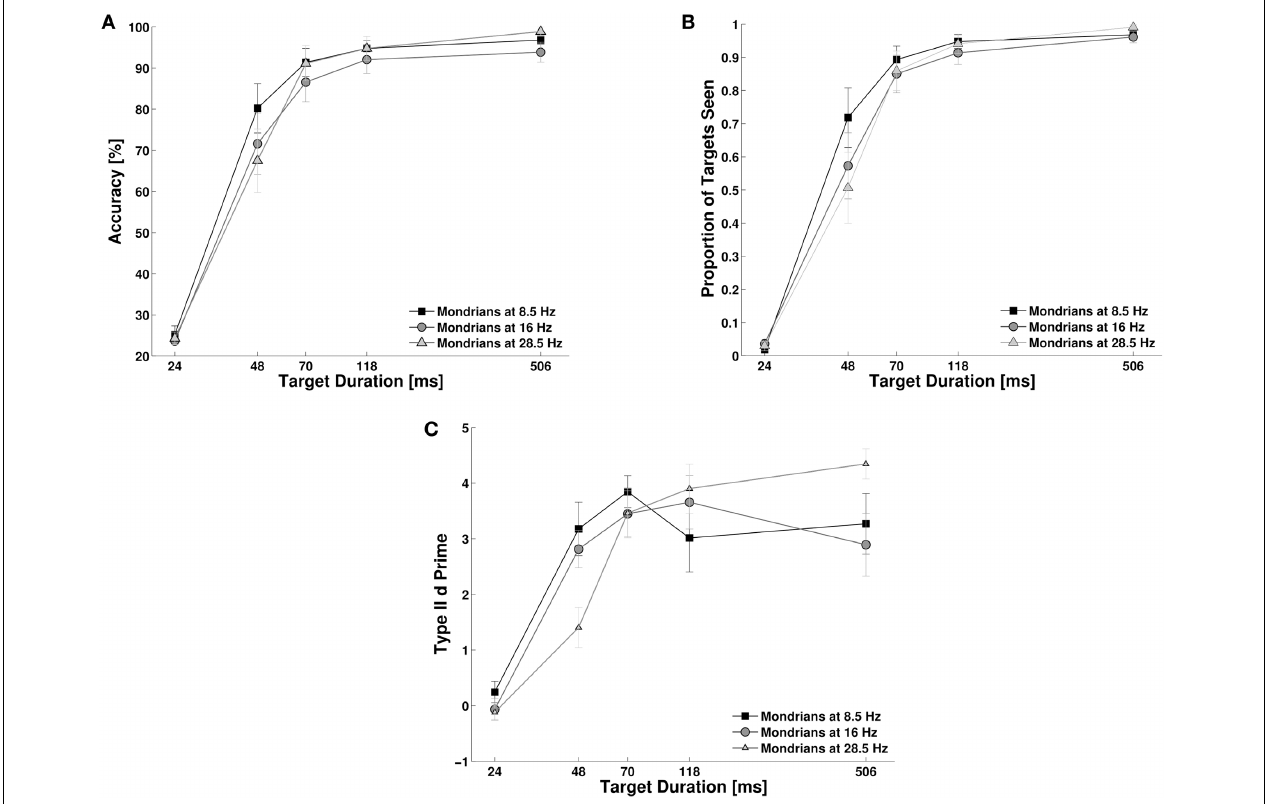
FIGURE 5 | Experiment 4. Target duration modulated inter-ocular suppression during CFS and affected objective performance (A) , subjective reports of visibility (B) , and metacognition (C) .